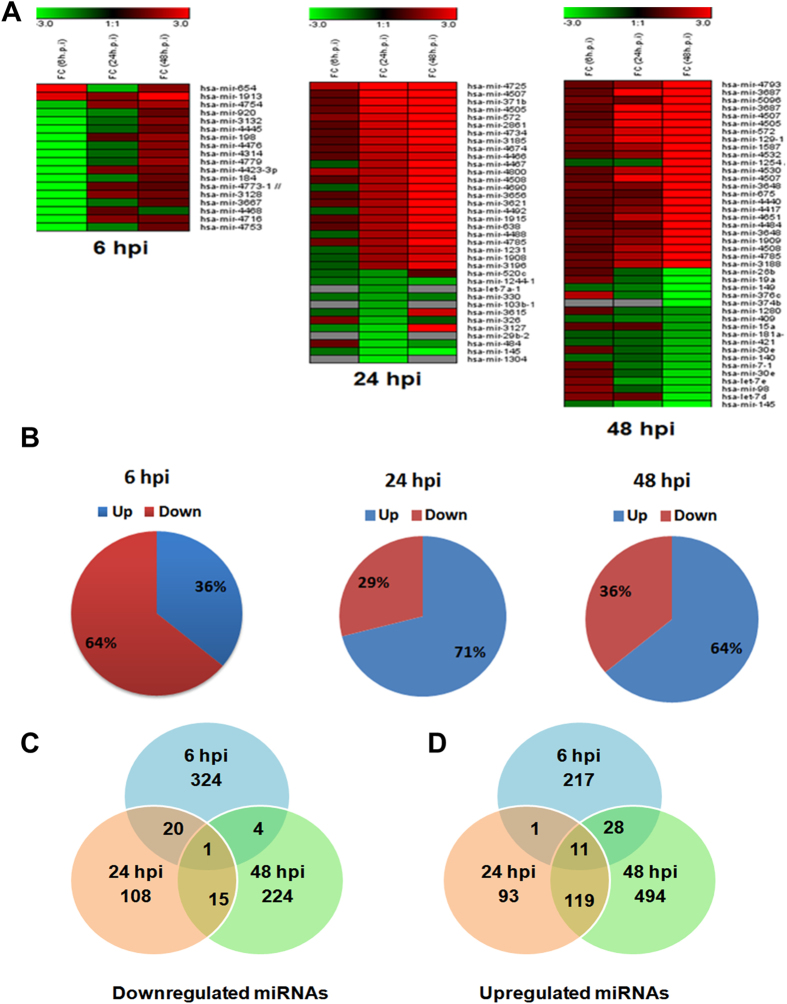
Cellular miRNAs signature in response to Japanese Encephalitis Virus infection in human microglial cell.(A) Heat map depicting the snapshot of miRNAs that are differentially expressed at 6 h pi, 24 h pi and 48 h pi. Red denotes upregulation and green denotes downregulation of miRNAs at particular time points. (B) Pie diagram are showing percentage of deregulated miRNAs at three different time points. (C,D) Venn diagrams show the number of common upregulated and down regulated miRNAs between different time points.